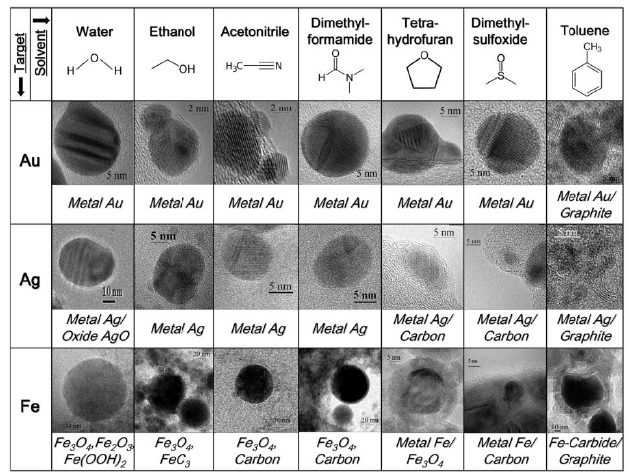
Figure 5. Summary of the NMs obtained by laser ablation of Au, Ag, and Fe bulk targets in different solvents with 9-ns pulses at 1064 nm and 10 J cm − 2 . Reprinted from [166], an open access article distributed under the Creative Commons Attribution License.